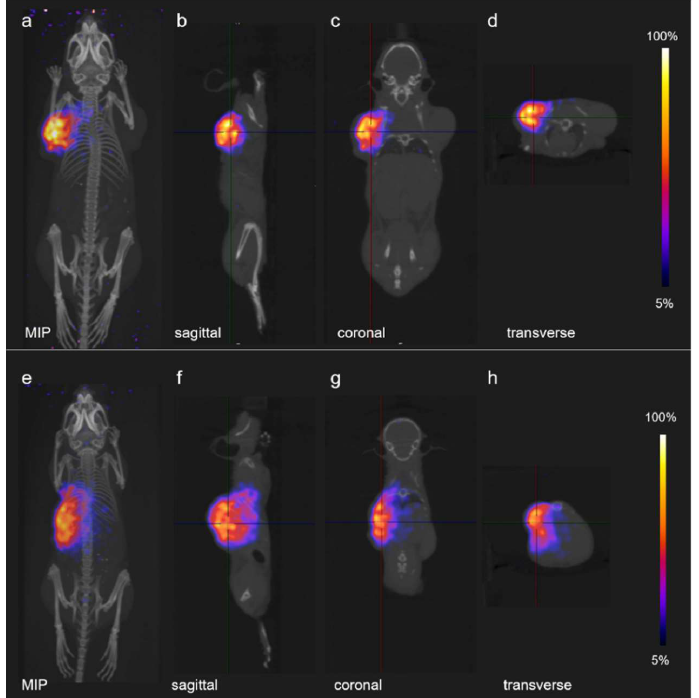
Figure 3. PET/CT images of proton induced activation in mice: ( a – d ) PET/CT images of a mouse bearing KB tumor xenografts; and ( e , f ) PET/CT images of a mouse bearing PC-3 PIP tumor xenografts. For both cases, the same proton dose of 20 Gy was delivered to the implanted tumor located on the left side of the mouse: ( a , e ) maximum intensity projections (MIP); ( b , f ) sagittal sections; ( c , g ) coronal sections; and ( d , h ) transverse